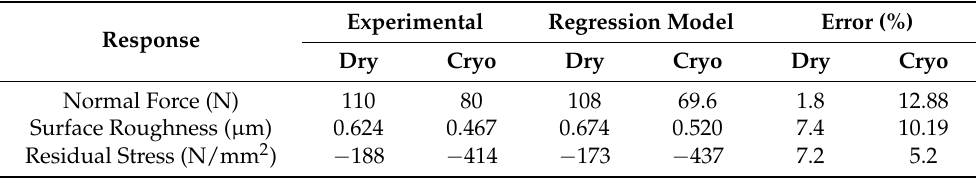
Table A2. Percentage deviation of regression model from experimental